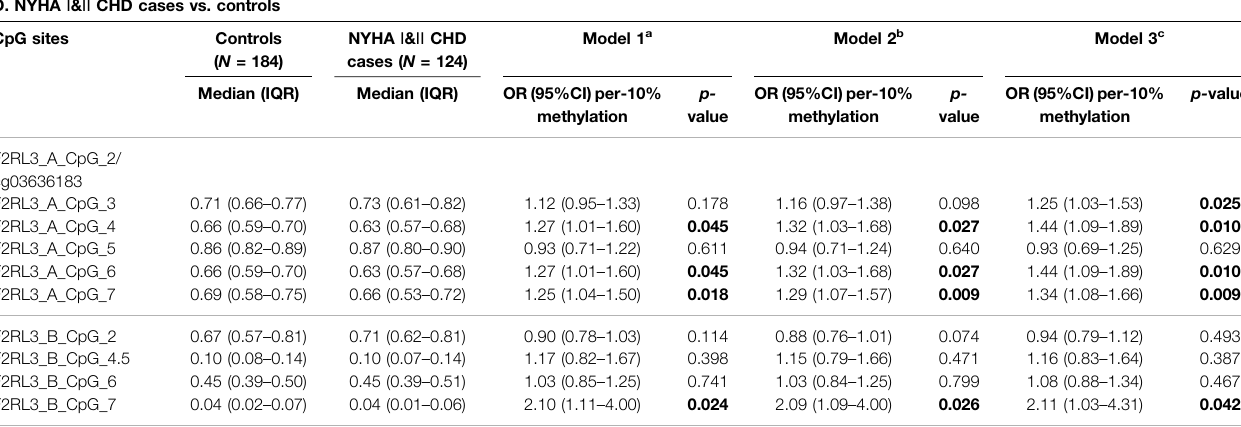
( Table 4 ). In contrast, only one CpG locus in the